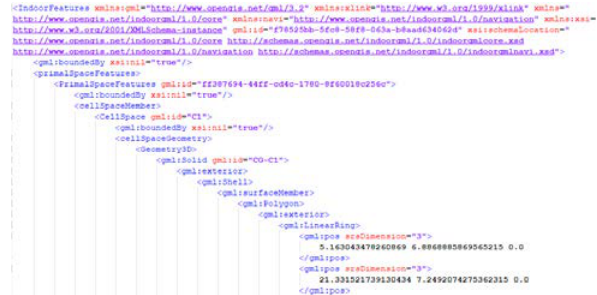
Figure 10. The data created by sample program